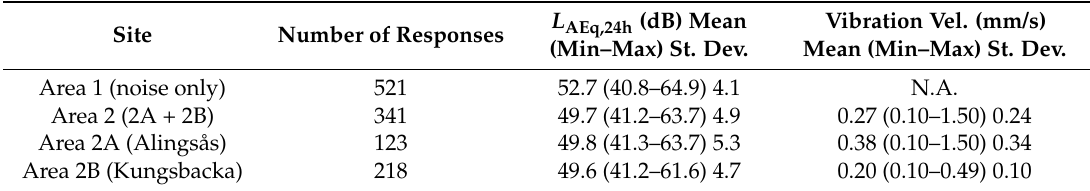
Table 2. Exposure for the questionnaire